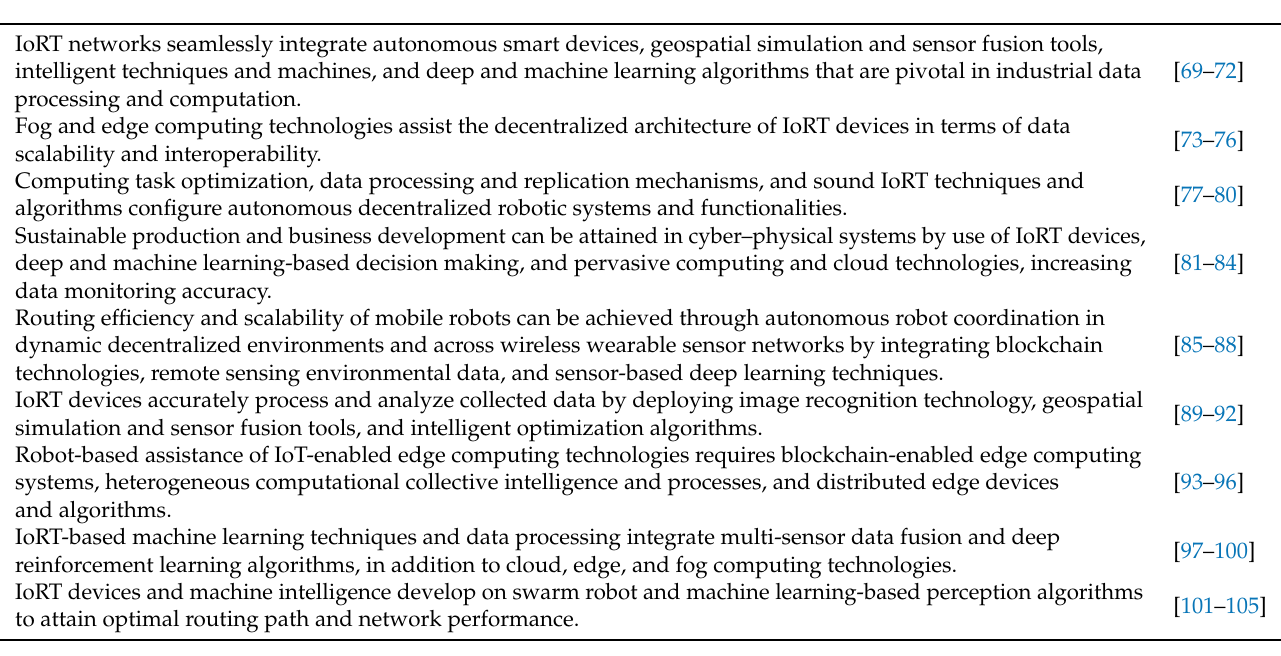
Table 5. Synopsis of evidence in relation to inspected topics and descriptive results (research